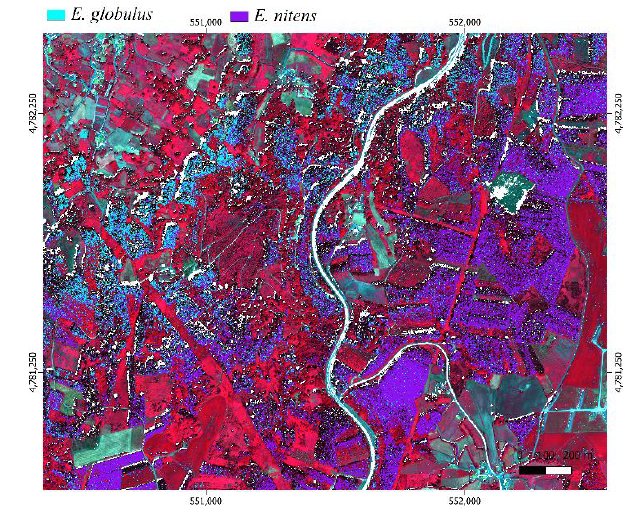
Figure 4. Example of result of the Eucalyptus species classification. Reference image WorldView image in false color infrared (B8, B5, B3). White correspond to shadowed